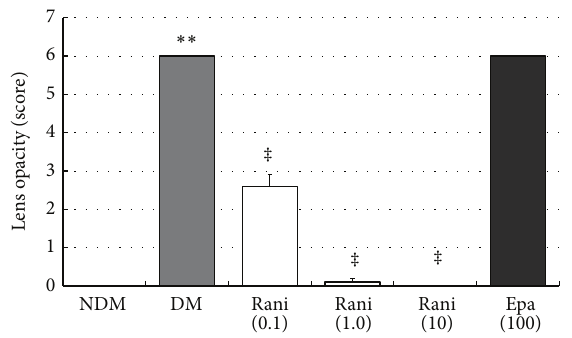
Figure 5: The total cataract scores at 40 weeks. The total cataract score of the untreated SDT rats at 40 weeks is significantly higher than that of the SD rats. ∗∗ 𝑃 < 0.01 , Wilcoxon rank sum test. The totalcataractscoreoftheSDTratstreatedwithranirestatat40weeks is significantly lower than that of the untreated SDT rats. ‡ 𝑃 < 0.01 , Wilcoxon rank sum test. There is no significant difference in the total cataract score between the untreated SDT rats and the SDT rats treated with epalrestat. NDM: non-diabetes mellitus; DM: diabetes mellitus; rani: ranirestat; epa: epalrestat.